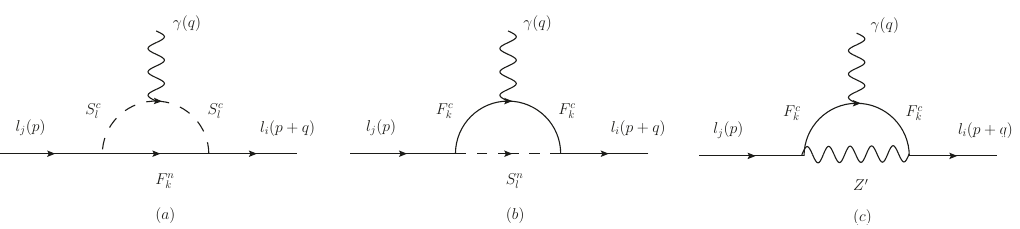
Figure 1 . One-loop Feynman diagrams which contribute to the lepton MDM. (a) represents the contributions to 4 a NP l